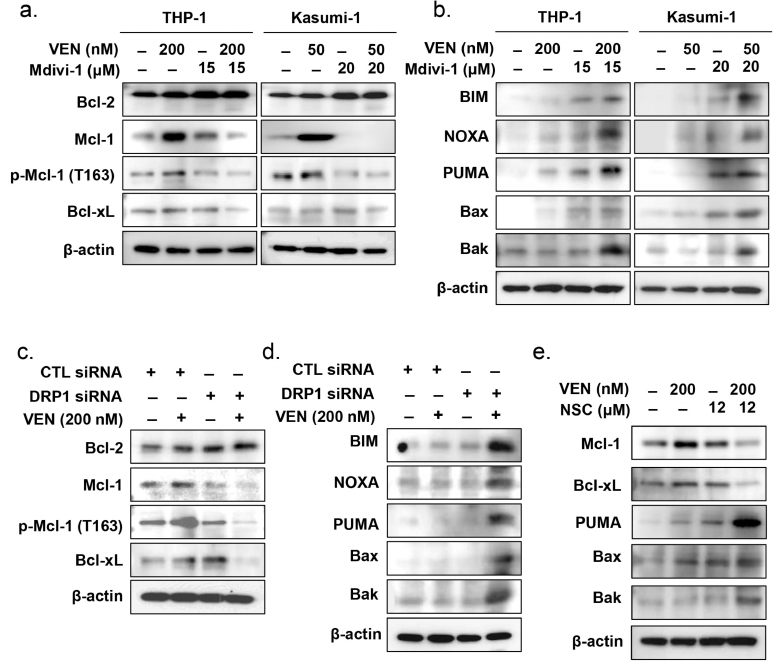
Figure 5. TP53-induced DRP1 inhibition reinforces BAX activation by downregulating MCL-1 and BCL-xL expression. ( a , b ) THP-1 and Kasumi-1 cells were treated with 200 or 50 nM venetoclax for 48 h in the presence or absence of 15 or 20 µ M Mdivi-1, respectively; cell lysates were subjected to